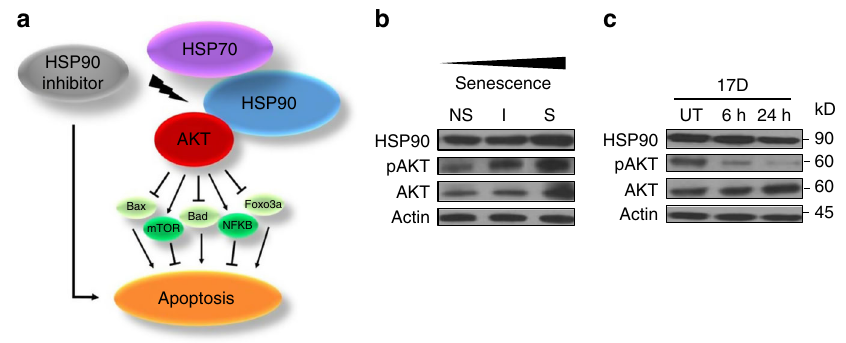
Fig. 8 Expression of heat shock proteins and HSP90 client proteins in senescent and non-senescent Ercc1 -/- MEFs. a Proposed model for how HSP90 promotes resistance to apoptosis in senescent, p5 Ercc1 − / − MEFs. b Immunoblot detection of HSP90, pAKT (Ser473), AKT, and actin in early passage, non-senescent cells (NS), intermediate passage (I), and late passage, senescent Ercc1 -de fi cient MEFs (S) grown at 20% O 2 . c Immunoblot detection of the same proteins in senescent, p5 Ercc1 − / − MEFs treated with 100 nM 17-DMAG at 6 and 24